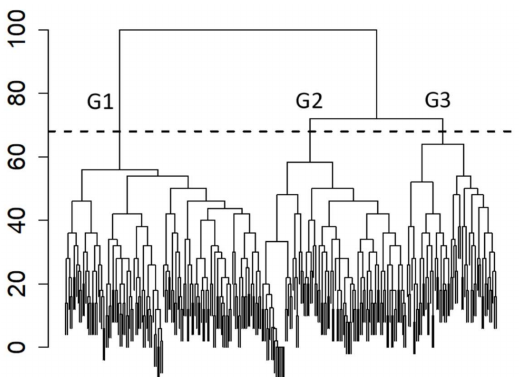
Figure 4. Cluster dendrogram of Fibromyalgia patients obtained from a multivariate analysis of Dizziness Handicap Inventory data (complete linkage agglomerative clustering with Manhattan distance). The height of each node (vertical axis) is the distance value between the right and left sub-branch clusters. The dendrogram reveals the presence of three groups designated Group 1 (G1), Group 2 (G2) and Group 3 (G3).